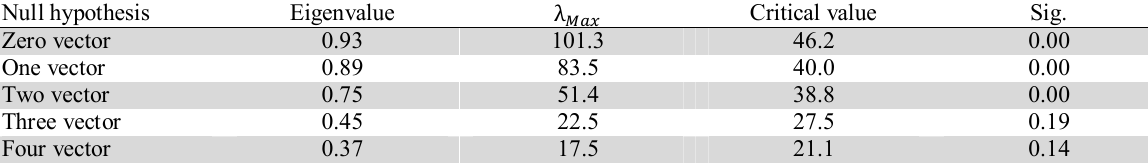
Critical value Sig.